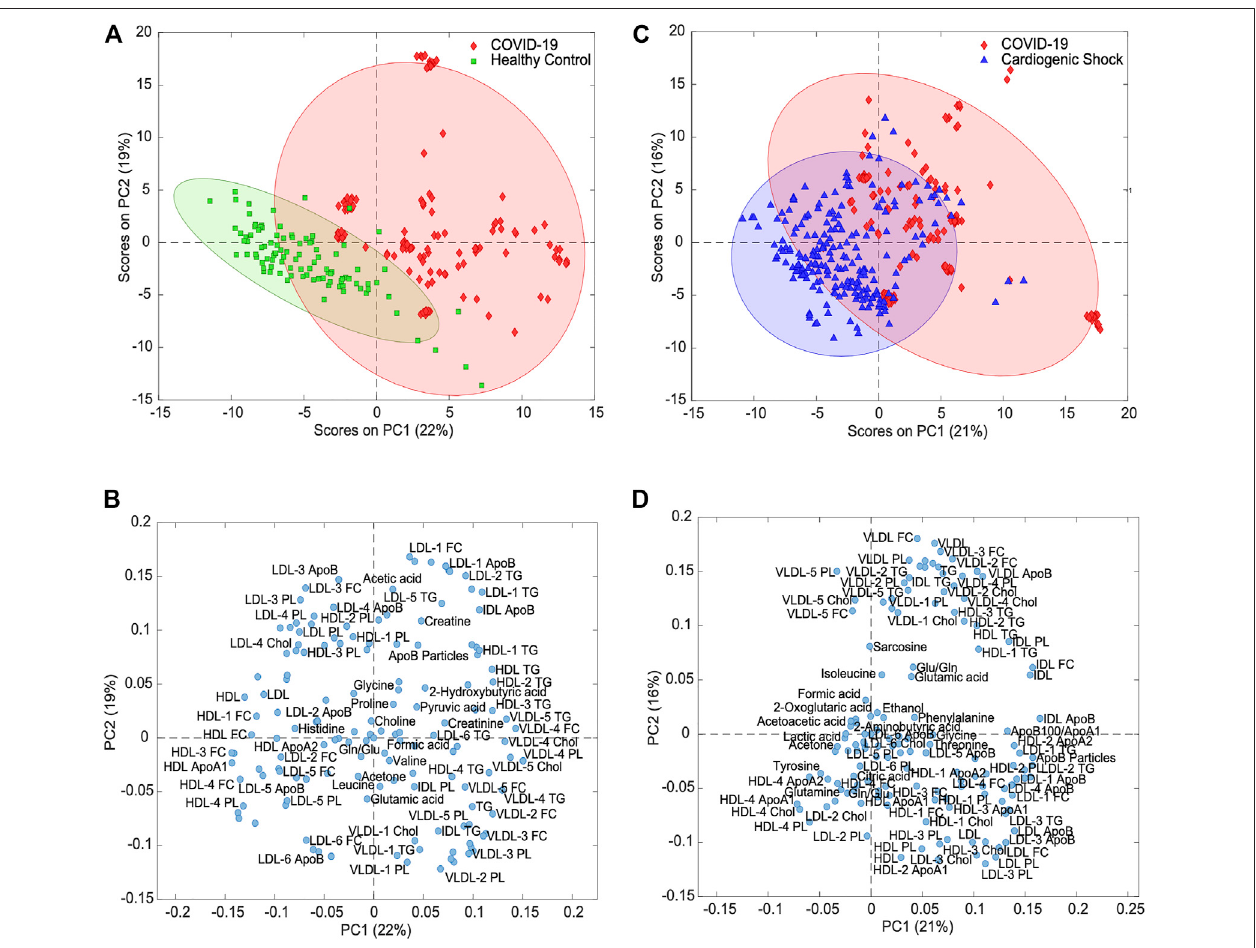
FIGURE 3 | Principal component analysis for variance-scaled and mean-centered IVDr NMR data. (A) Scores plot of COVID-19 samples (red) vs. healthy controls (green)showinggoodseparationoftwogroups. (B) LoadingsplotofsamePCAshowingselectionofmetabolitesandlipoproteins. (C) PCAscoresplotofCOVID-19(red)vs. cardiogenic shock samples (blue) showing partial separation of two groups. (D) Loadings plot of same PCA showing groups of correlated metabolites and